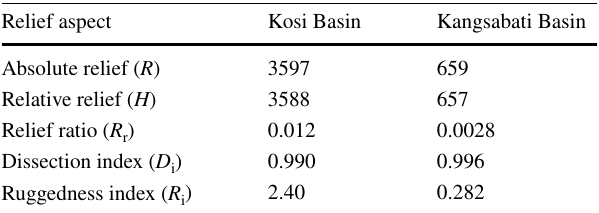
Table 3 Areal morphometric aspects of river basins Relief